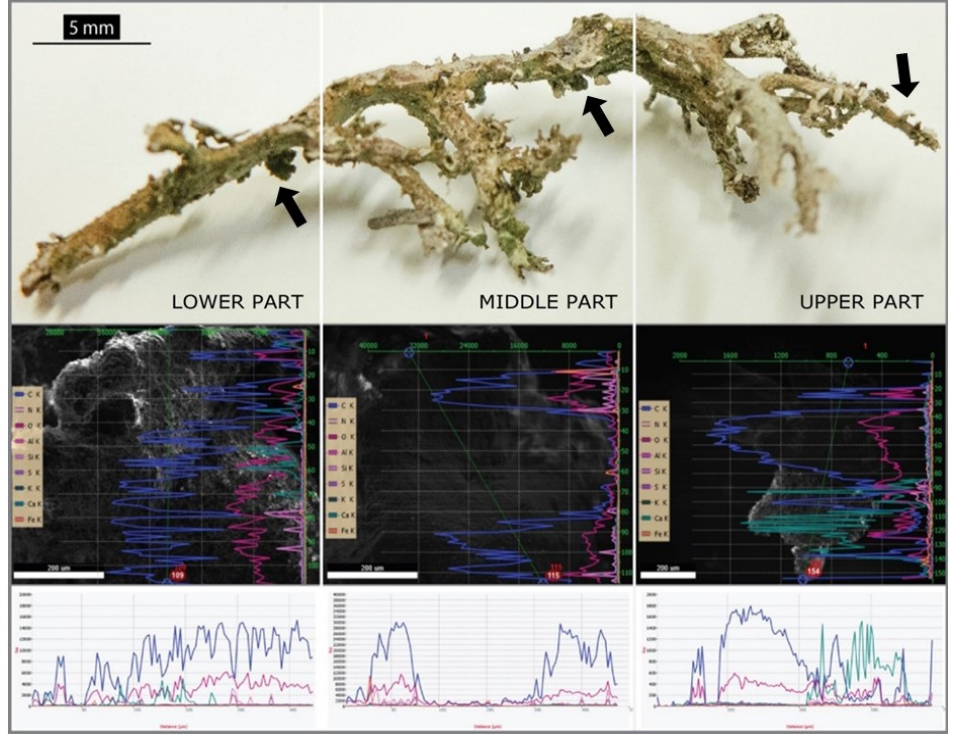
Figure 1. Line scans of three selected parts of lichen Cladonia furcata (turquoise color represents Ca), where the highest amount was measured in the upper part of the lichen thallus. Black arrows indicate squamules.